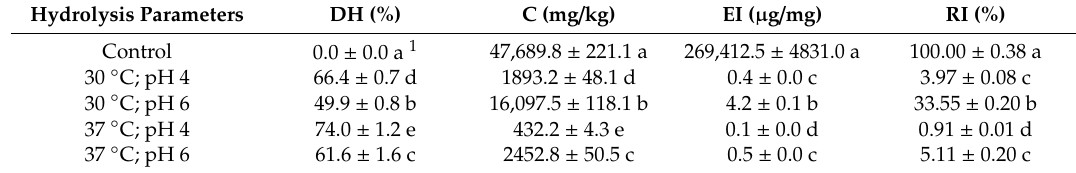
Table 2. E ff ect of reaction conditions on the degree of hydrolysis (DH, %), concentration of a QQPFP sequence (C, mg / kg), e ff ective immunoreactivity (EI, µ g / mg) and relative immunoreactivity (RI, %) of gliadins hydrolysed by a mixture of peptidases from L. acidophilus 5e2 and A. niger . Hydrolysis Parameters DH (%) C (mg / kg) EI ( µ g / mg) RI (%)